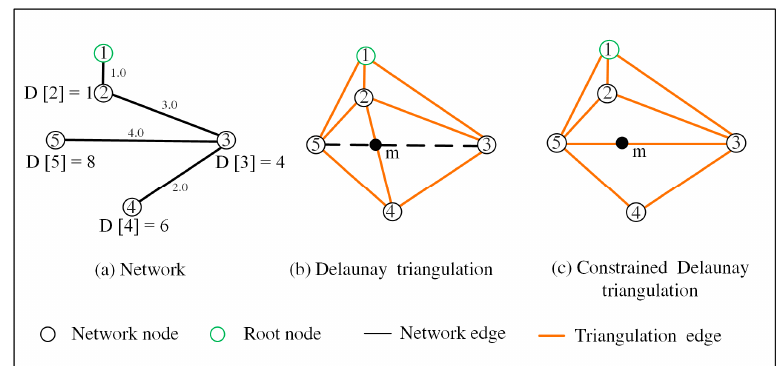
Figure 6. Illustration of the interpolations based on the Delaunay and constrained Delaunay triangulations.